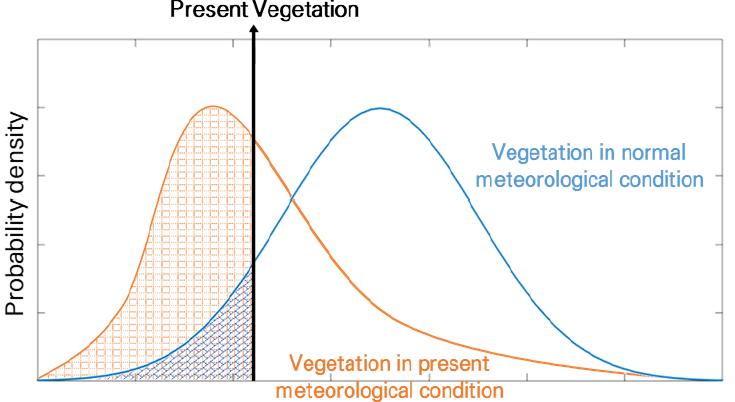
Figure 3. Probabilistic analysis of ecological drought condition of vegetation during meteorological drought.